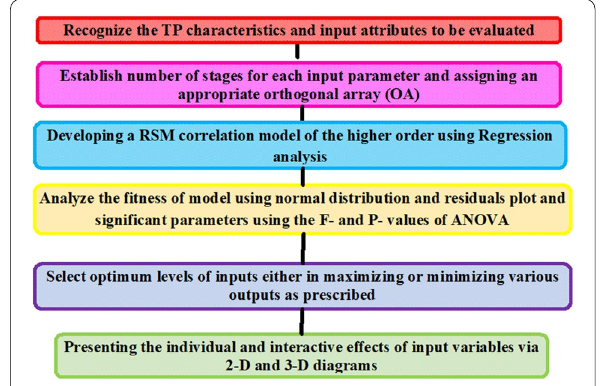
Fig. 1 Various steps involved in the RSM process